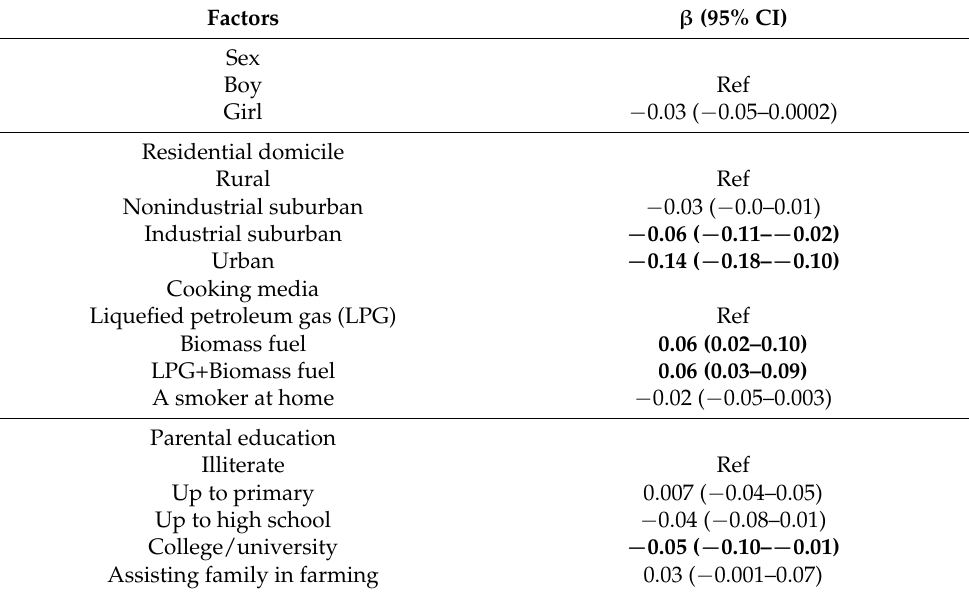
Table 5. Associations between living conditions/socioenvironmental factors and total rMEQ